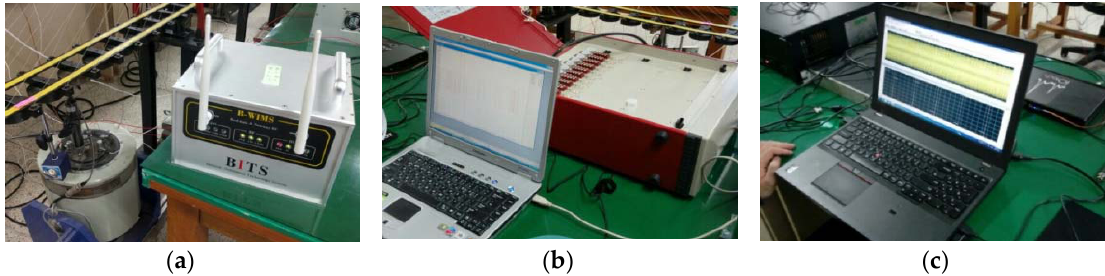
Figure 6. Response test using a modal shaker: ( a ) Wireless responses (displacement and acceleration) test; ( b ) wired response (displacement) test; ( c ) wired response (acceleration) test.